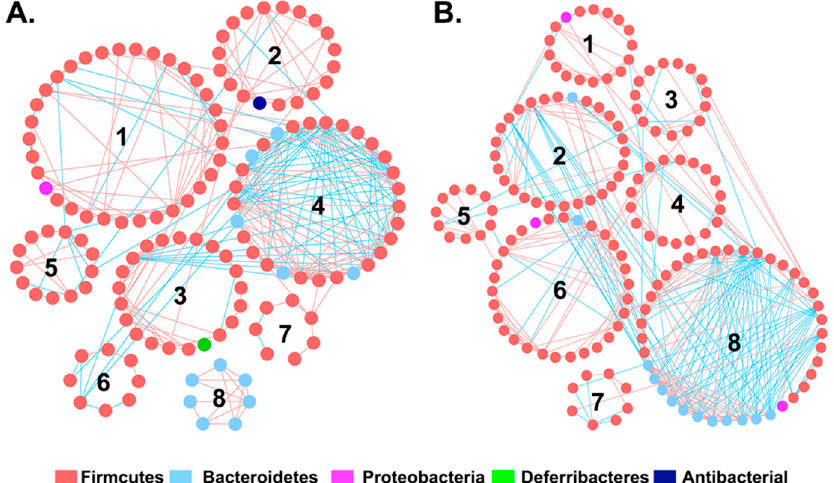
Figure 2. Intestinal microbiota network interactions under the ( A ) control and ( B ) I3C diet. Each node signified a species. Node colors indicate different phyla. A red line indicates a positive interaction between two individual nodes, suggesting a mutualism or cooperation, while a blue line indicates a negative interaction, suggesting predation or competition. The numbers 1 through 8 indicate number of modules in each